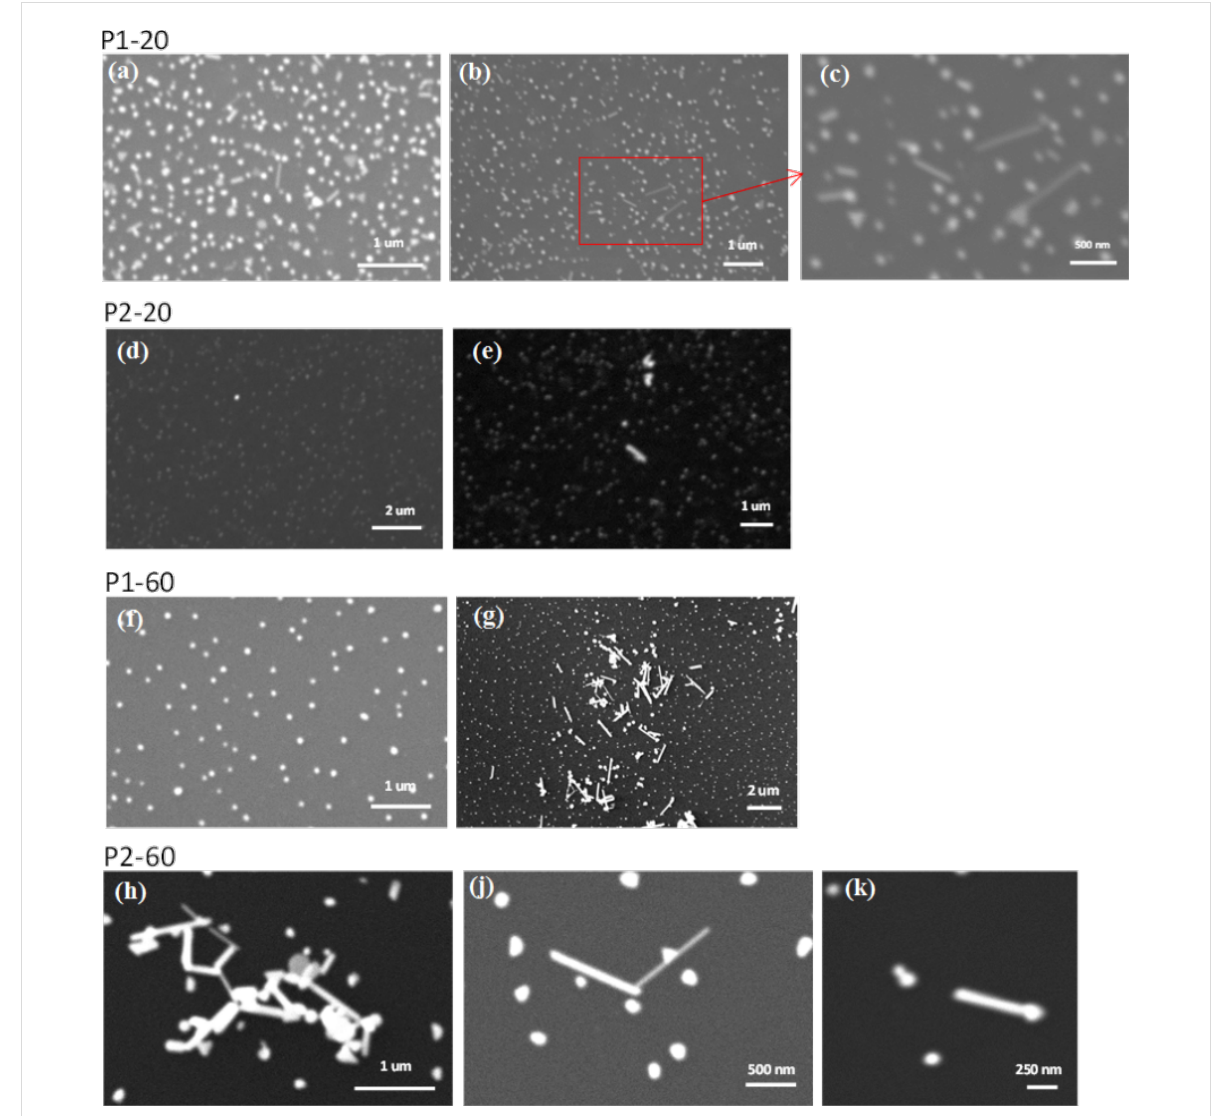
Figure 5: SEM images of different regions of Au–PMMA nanocomposites. (a–c) Low M w PMMA with 20 wt % Au salt (P1-20); (d,e) high M w PMMA with 20 wt % Au salt (P2-20), (f,g) low M w PMMA with 60 wt % Au salt concentration (P1-60) and (h–k) high M w PMMA with 60 wt % Au salt concen- tration